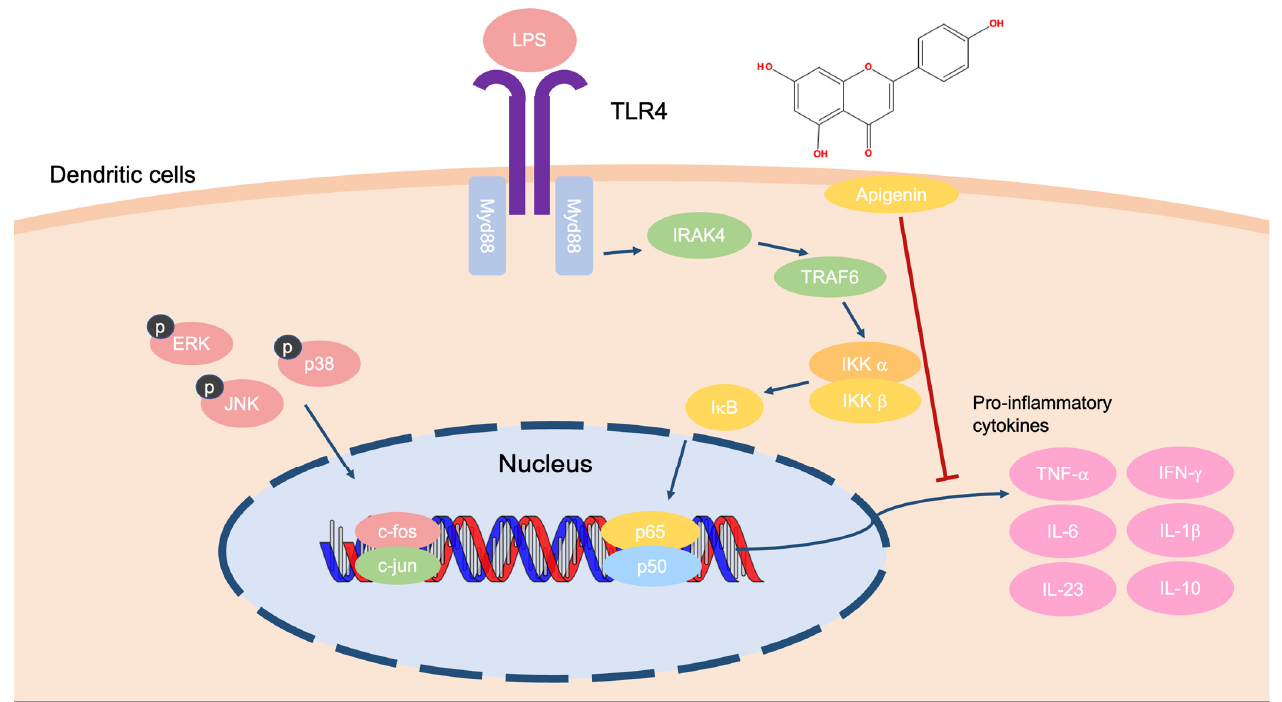
Figure 6. The mechanism of apigenin in LPS-treated